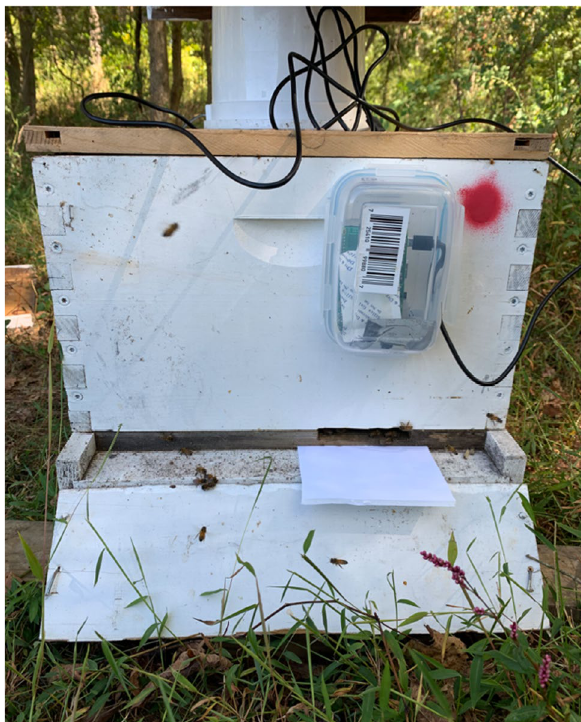
Figure 4. Receiver colony mounted with camera sensor.